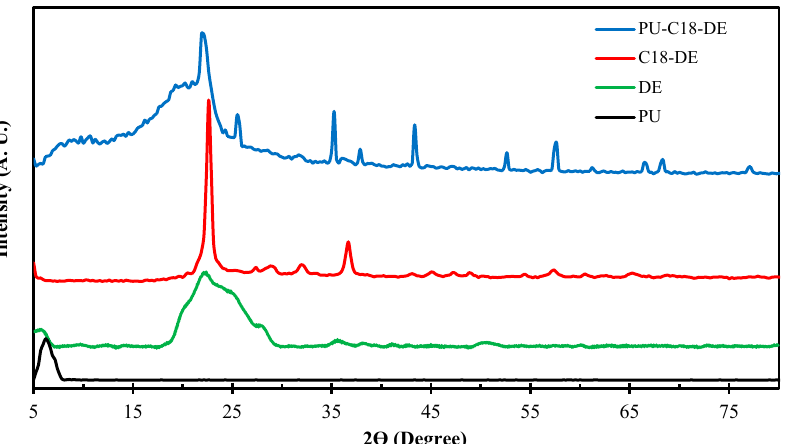
Figure 1. Powder XRD spectra of PU (bottom), DE, C18-DE particles and PU-C18-DE (top). XRD spectra of PU-C18-DE show an increment in crystallinity due to the incorporation of modified silane DE particles in amorphous PU foam.